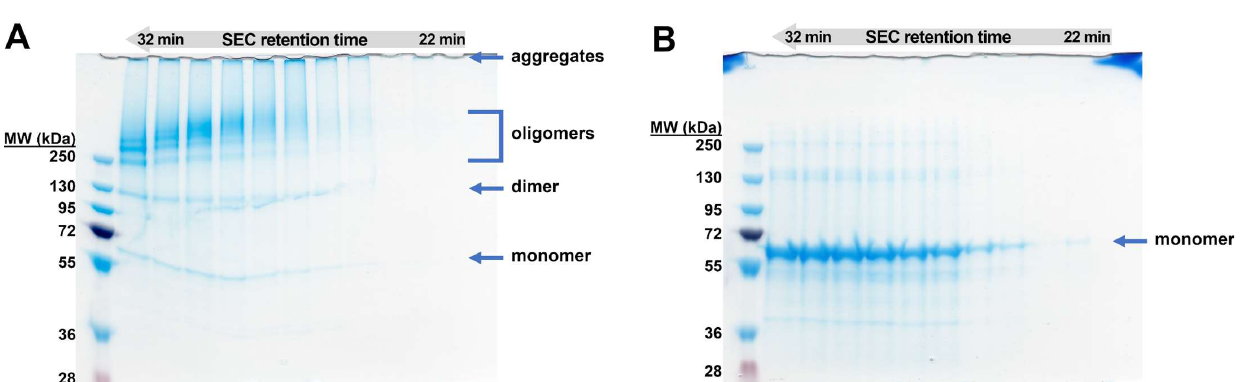
Figure 5. SDS-PAGE analysis in non-reducing ( A ) and reducing ( B ) conditions of the consecutive SEC-MALS oligomer fractions with the elution time range of 22–32 min. An amount of 10 μg was loaded into each well. The average mass distribution over the analyzed fractions in the non-reducing conditions is inversely proportional to the SEC-MALS elution time, as expected. The higher the molecular weights, the more unstable the cytotoxin. The oligomeric fractions additionally contain monomer, dimer, and aggregates. The efficient oligomers monomerization was observed in the reducing conditions.